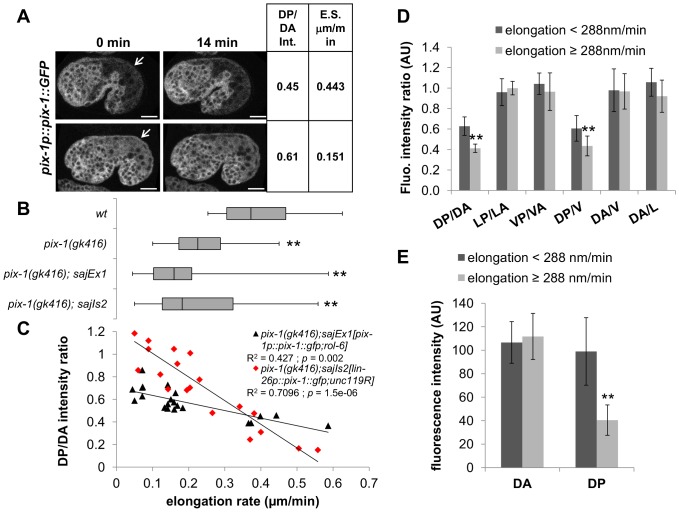
High expression of PIX-1::GFP in dorsal posterior hypodermis is detrimental for elongation rate of embryos.A) Confocal projections of pix-1(gk416); sajEx1[pix-1p::pix-1::GFP, rol-6] at t = 0 min and t = 14 min. The DP/DA fluorescence intensity ratio and elongation rate (in μm/min) are indicated. Arrows indicate the dorsal-posterior hypodermis. Scale bar: 10 µm. B) Distribution of elongation rate in μm/min of wild-type (wt), pix-1(gk416), and pix-1(gk416) animals carrying sajEx1[pix-1p::pix-1::GFP, rol-6] or sajIs2[lin-26p::pix-1::GFP, unc-119R] during early elongation. Elongation rate was measured from 4-dimensional recording of embryonic development between comma and the end of early elongation upon DIC illumination. Box-plots represent the min, max, 25th, 50th (median) and 75th percentile of the populations. ** T-test p<0.01 vs wt. C) Scatter plot representing the relationship between the dorsal-posterior/dorsal-anterior (DP/DA) intensity ratio of PIX-1::GFP and the elongation rate in μm/min during early elongation of pix-1(gk416) embryos carrying sajEx1[pix-1p::pix-1::GFP, rol-6] or sajIs2[lin-26p::pix-1::GFP, unc-119R] (n = 20 for each line). The spearman correlation (R2) between the elongation rate and the DP/DA ratio are indicated, as well as the p-values rejecting the null hypothesis being that the two values are not significantly correlated. Similar results were obtained for pix-1(gk416) animals carrying sajIs1 and sajIs3 (see methods). D) DP/DA, lateral-posterior/lateral-anterior (LP/LA), ventral-posterior/ventral-anterior (VP/VA), dorsal-posterior/ventral (DP/V), dorsal-anterior/ventral (DA/V) and dorsal-anterior/lateral (DA/L) fluorescence intensity ratio measured for pix-1(gk416); sajEx1[pix-1p::pix-1::GFP, rol-6] embryos elongating at a wt-rate (elongation≥288nm/min) or elongating slower (elongation<288nm/min) during early elongation. Bar correspond to the mean and error bars to the standard deviation. ** T-test p-value<0.01. E) PIX-1::GFP fluorescence intensity (AU) was measured in DA and DP hypodermal cells of embryos elongating at a wt-rate (elongation≥288nm/min) or elongating slower (elongation<288nm/min) during early elongation (see methods). ** T-test p-value<0.01.